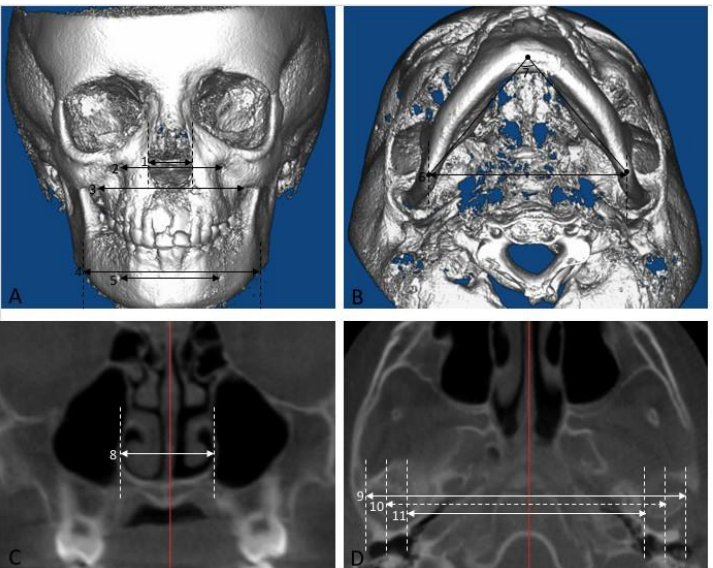
Figure 2. Skeletal measurements. The transverse width of various non-tooth-bearing areas of the maxilla and mandible was measured (“Skeletal measurements”). ( A ) 1. Anterior nasal width, 2. Io- Io, 3. Mx-Mx, 4. Ag-Ag, 5. Mf-Mf. ( B ) 6. Go-Go, 7. Gonion triangle. ( C ) 8. U6 nasal width. ( D ) 9. Cd- Cd lateral, 10. Cd-Cd middle, 11. Cd-Cd